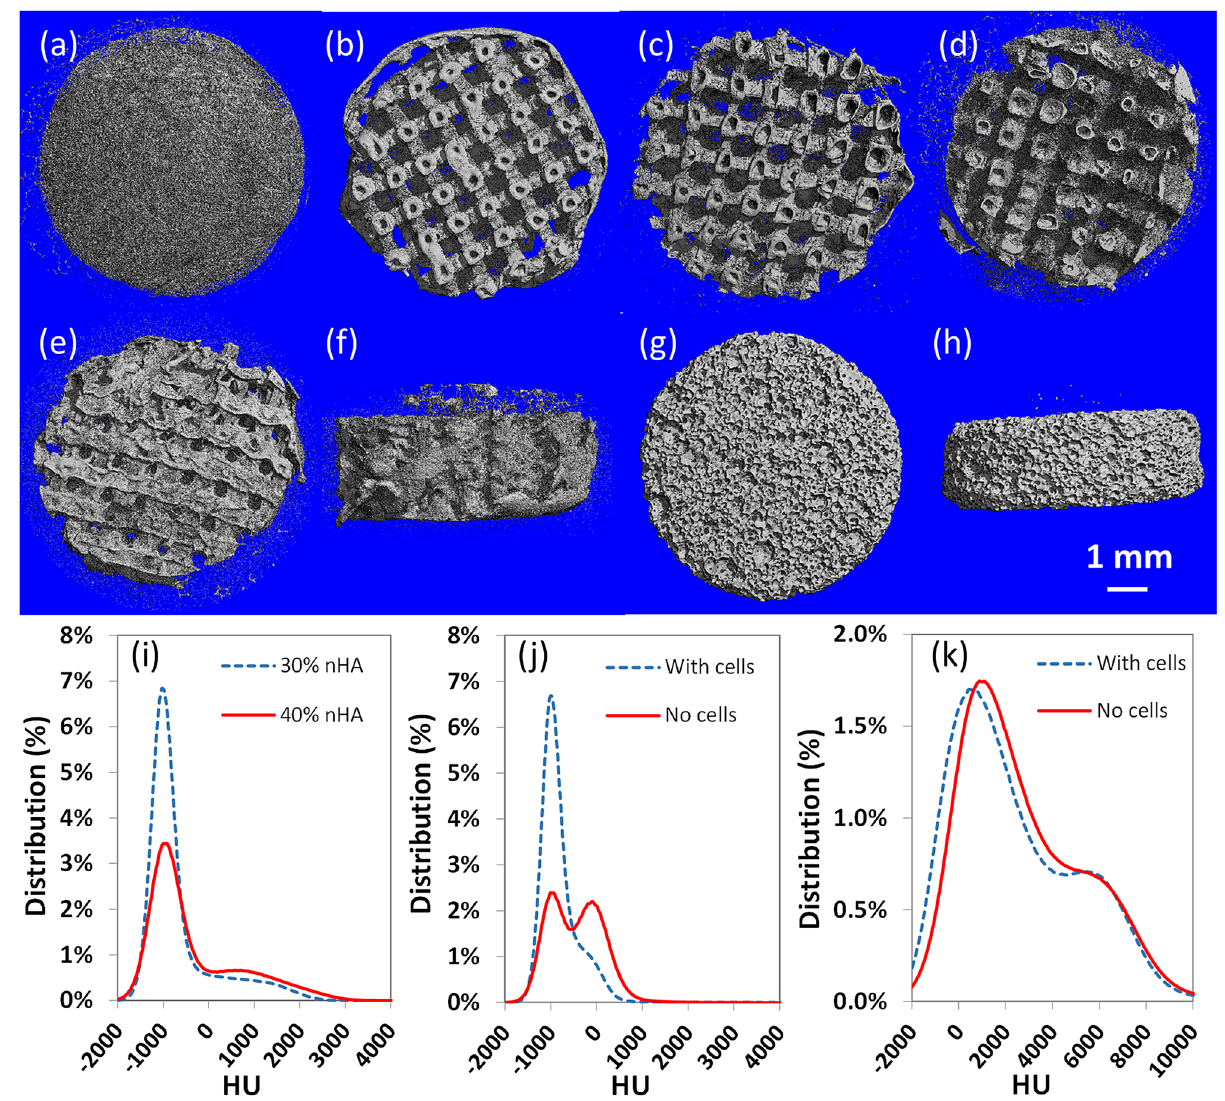
Fig. 5 The µCT images showing a the top view of a PLGA/nHA scaffold prepared using the TIPS-only method (provided for com- parison), b – d the top views of scaffold #2, scaffold #6, and scaf- fold #14, respectively, e & f the top and side views of scaffold #14 after two weeks of culture inside the bioreactor, (g & h) the top and side views of CellCeram ™ scaffold after two weeks of culture inside